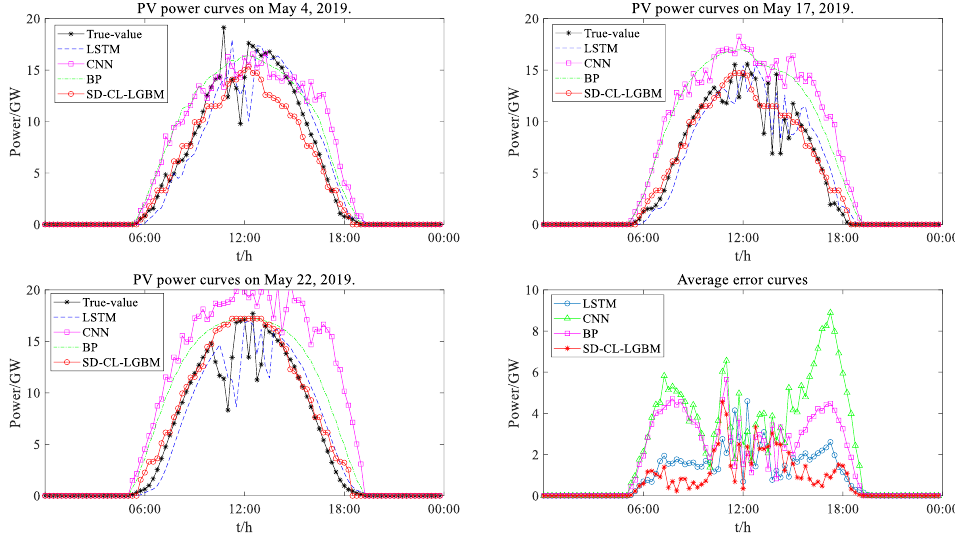
Figure 13. Comparison of prediction results of different models for non-sunny target days.